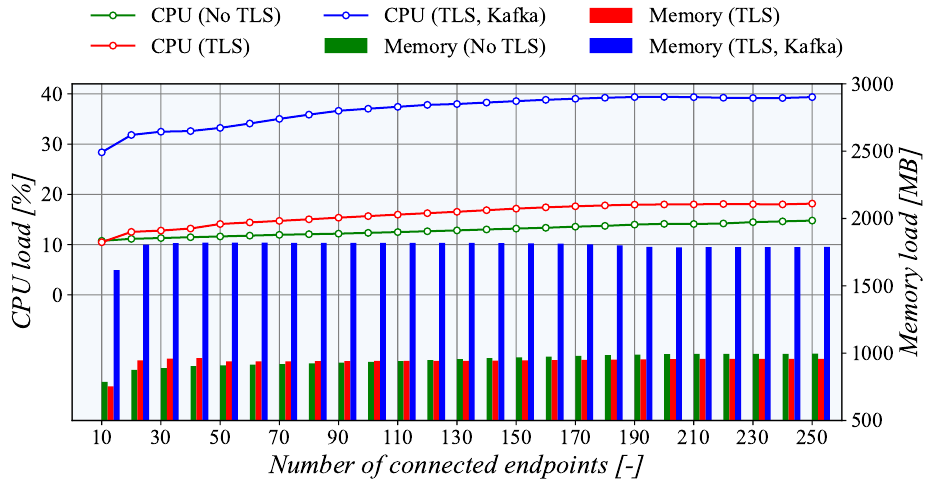
Figure 13. Utilization of system resources on the collector side in a PUSH